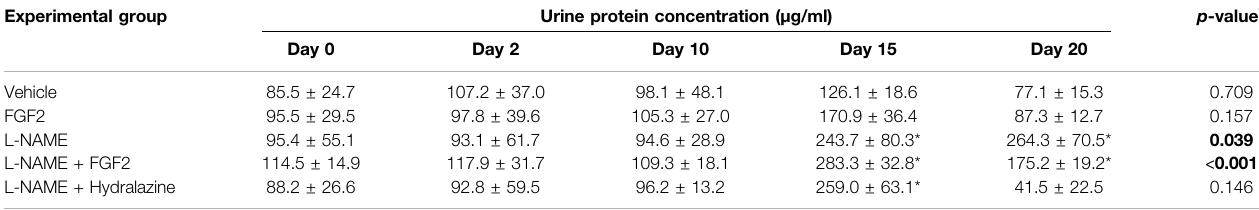
TABLE 1 | Comparison of urinary protein concentrations between study groups. Experimental group Urine protein concentration (µg/ml) p -value † Day 0 Day 2 Day 10 Day 20 Vehicle